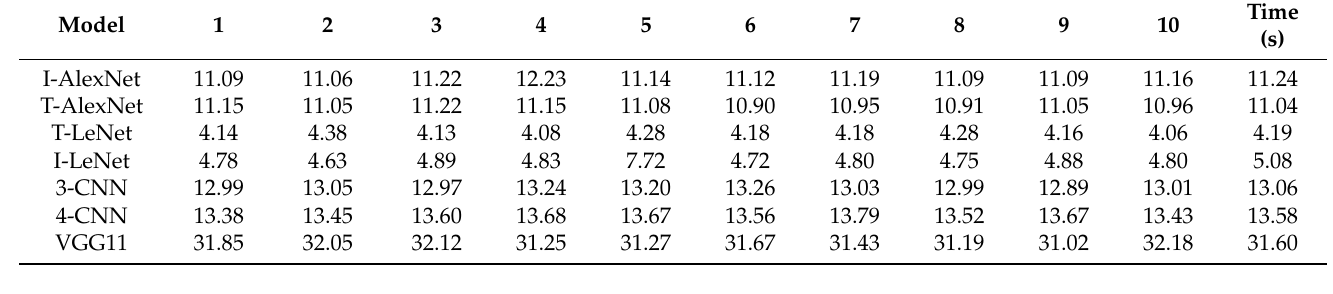
Table 5. Computational time of different CNN models in one epoch.